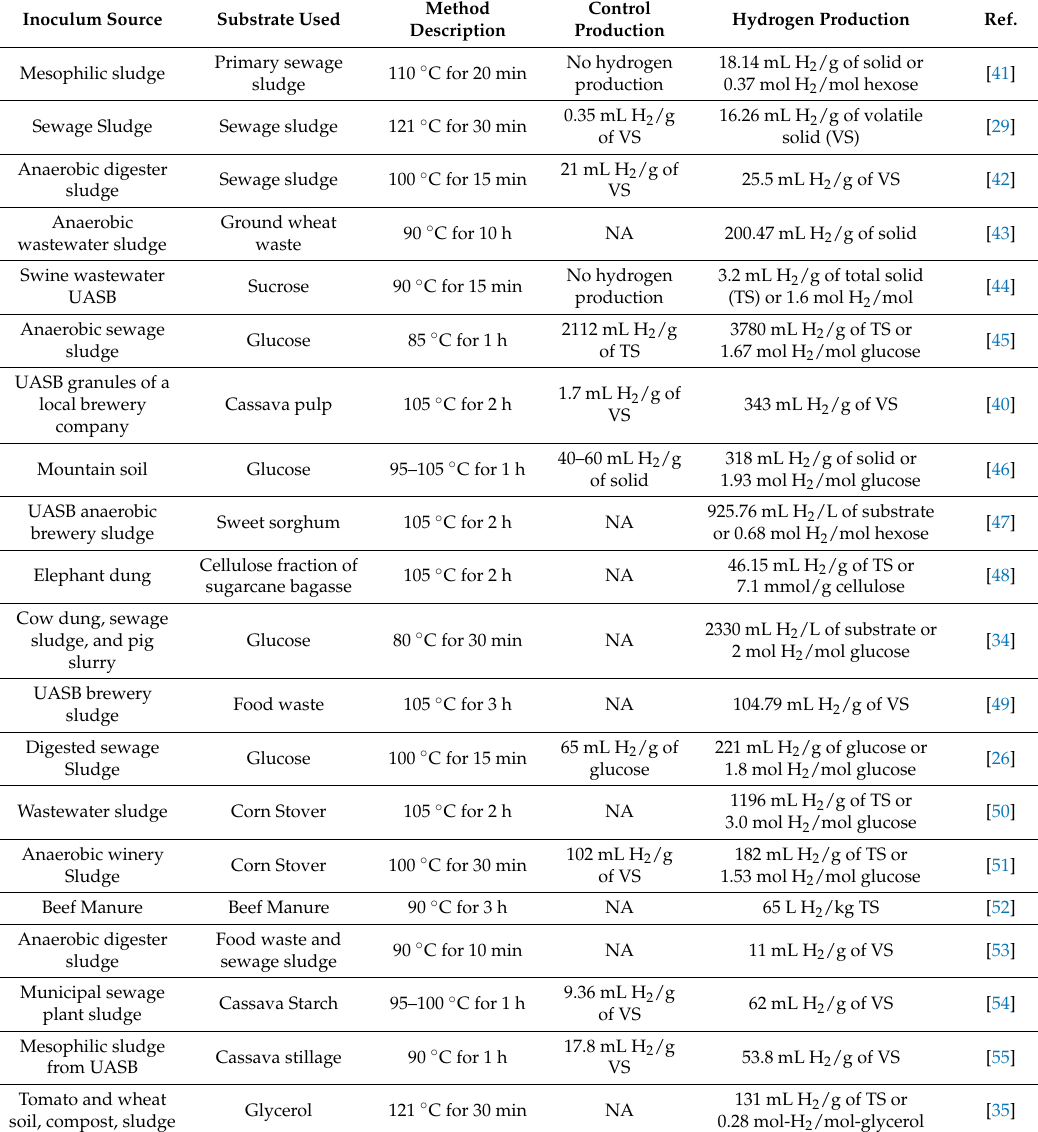
Table 1. Hydrogen yield by mixed-culture system using heat